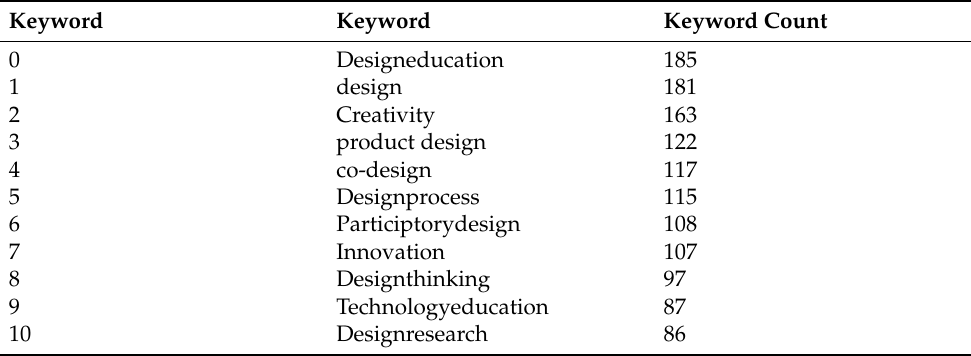
Table 2. The keywords with the highest